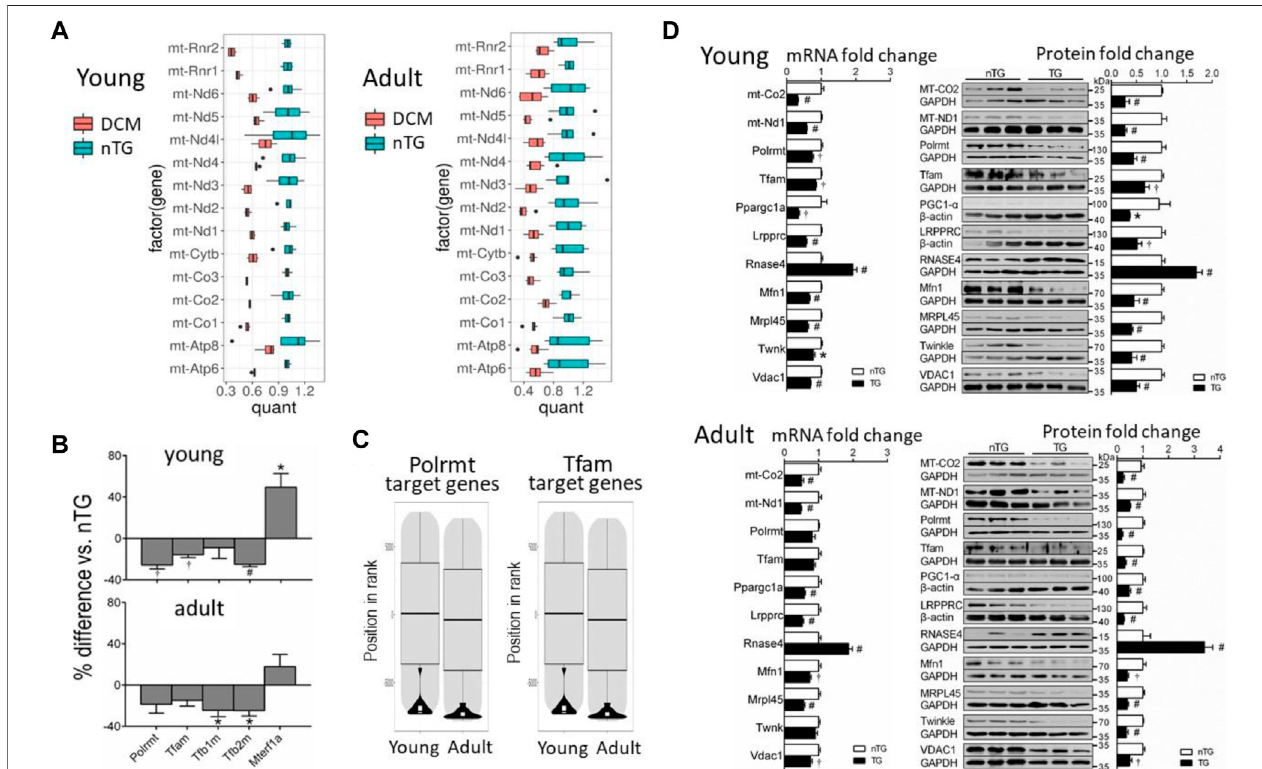
FIGURE 2 | Altered expression of mitochondrial mRNAs and nDNA-encoded genes for mtDNA transcription activators or promoters in DCM hearts. (A) Boxplots showingdownregulatedexpressionofmitochondrialmRNAsinDCMhearts.Resultswerenormalisedtothemeanofthecontrolsamples.Theboxheightrepresentsthe interquartile range. Changes in all genes were statistically signi fi cant. Dots are outlier points de fi ned as a data point, that is, located 1.5 times outside the interquartile range above the upper/lower quartile. (B) Bar graphs showing changes in gene expression of mtDNA transcription activators. Polrmt, RNA polymerase mitochondrial; Tfam, transcription factor A mitochondrial; Tfb1/2m, transcription factor B1/2 mitochondrial; Mterf1a, mitochondrial transcription termination factor 1a. (C) Violin plots depicting suppression of mtDNA transcription factors Polrmt target genes. (D) Bar graphs showing relative expression levels of selected mRNAs (RNA- sequencing) and proteins ( n = 6 per group) for comparison. For panels B and D, * p < 0.05, † p < 0.01, # p < 0.001 vs. respective